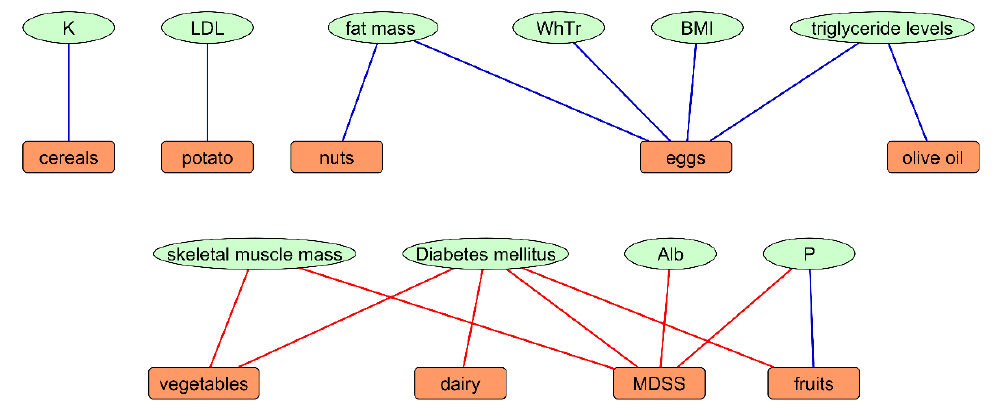
Figure 2. Summary presentation of signifficant associations between adherence to components of the MeDi and researched parameters in Dalmatian KTRs. Explanation: red lines represent positive associations (OR > 1, p < 0.05), while blue lines represent negative associations (OR < 1, p < 0.05).